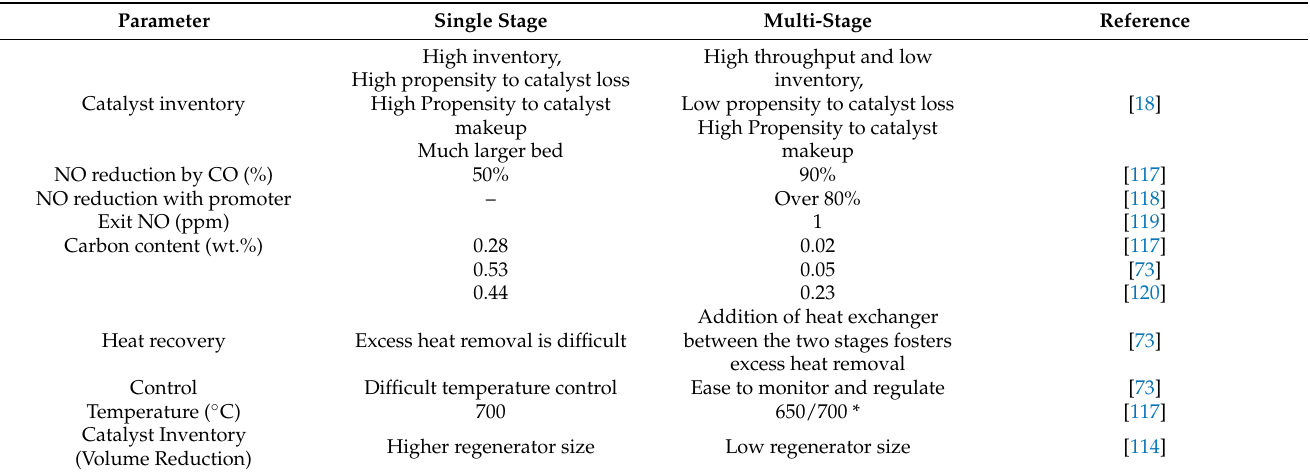
Table 3. Comparative performance of single- and multi-stage regenerators.